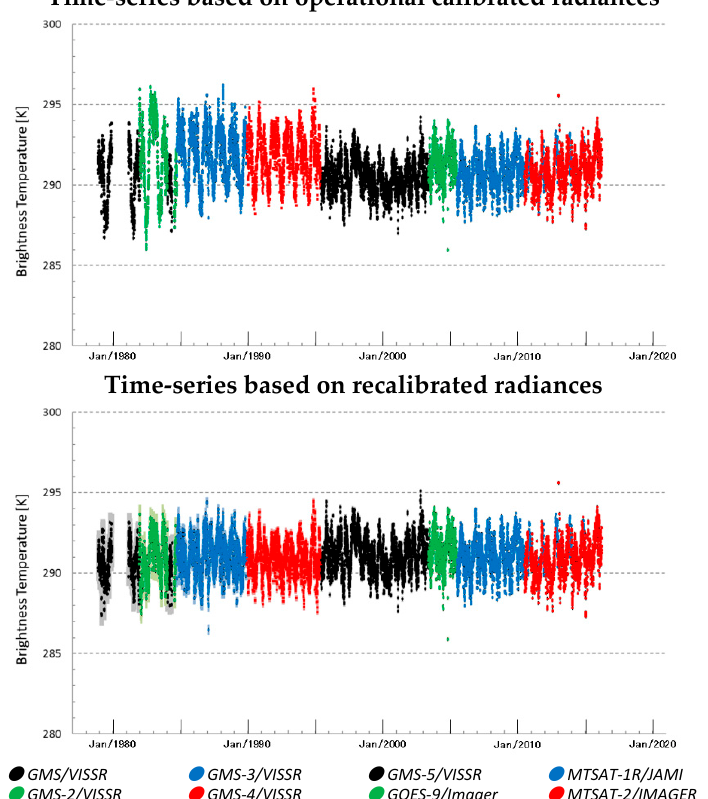
Figure 11. Time-series of baseline sensor normalized GMS, GMS-2, GMS-3, GMS-4, GMS-5, GOES-9, MTSAT-1R and MTSAT-2 clear sky radiances (presented as brightness temperatures) for the IR channel, taking MTSAT-2 as the baseline sensor. The upper panel presents the time-series using the operational calibration, whereas the lower panel presents the time-series for the recalibrated calibration. The data points represent daily average values for the area 30N–30S, sub-satellite longitude − 30 ◦ –sub-satellite longitude + 30 ◦ derived from 6 hourly data. The shaded areas in the lower panel represent 1 σ uncertainty due to the recalibration.